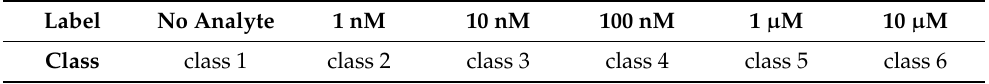
Table 3. The available segments’ labels and their corresponding classes.